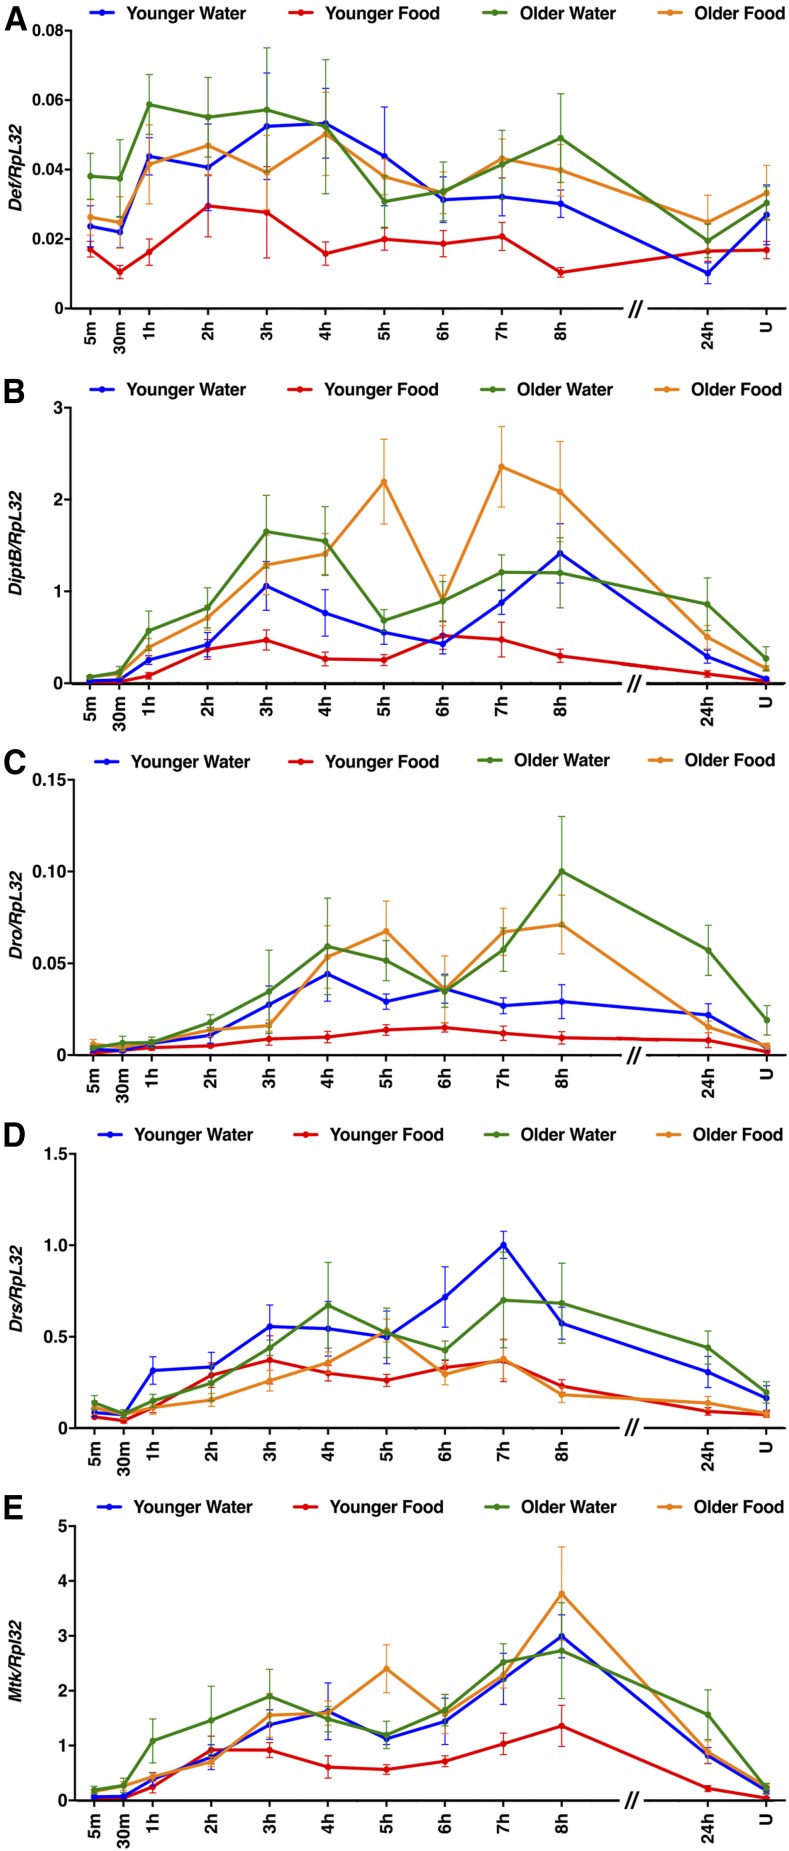
Age and diet affected expression of some AMP family genes following primary injuries. (A–E) Expression of the indicated genes relative to RpL32 following the standard injury protocol in w1118 flies under the indicated conditions. Note that y-axis scales are different among graphs and that the x-axis is not to scale between 8 and 24 hr. U indicates uninjured flies at the 24 hr time point. Each data point is the average and SEM of at least three biological replicates.